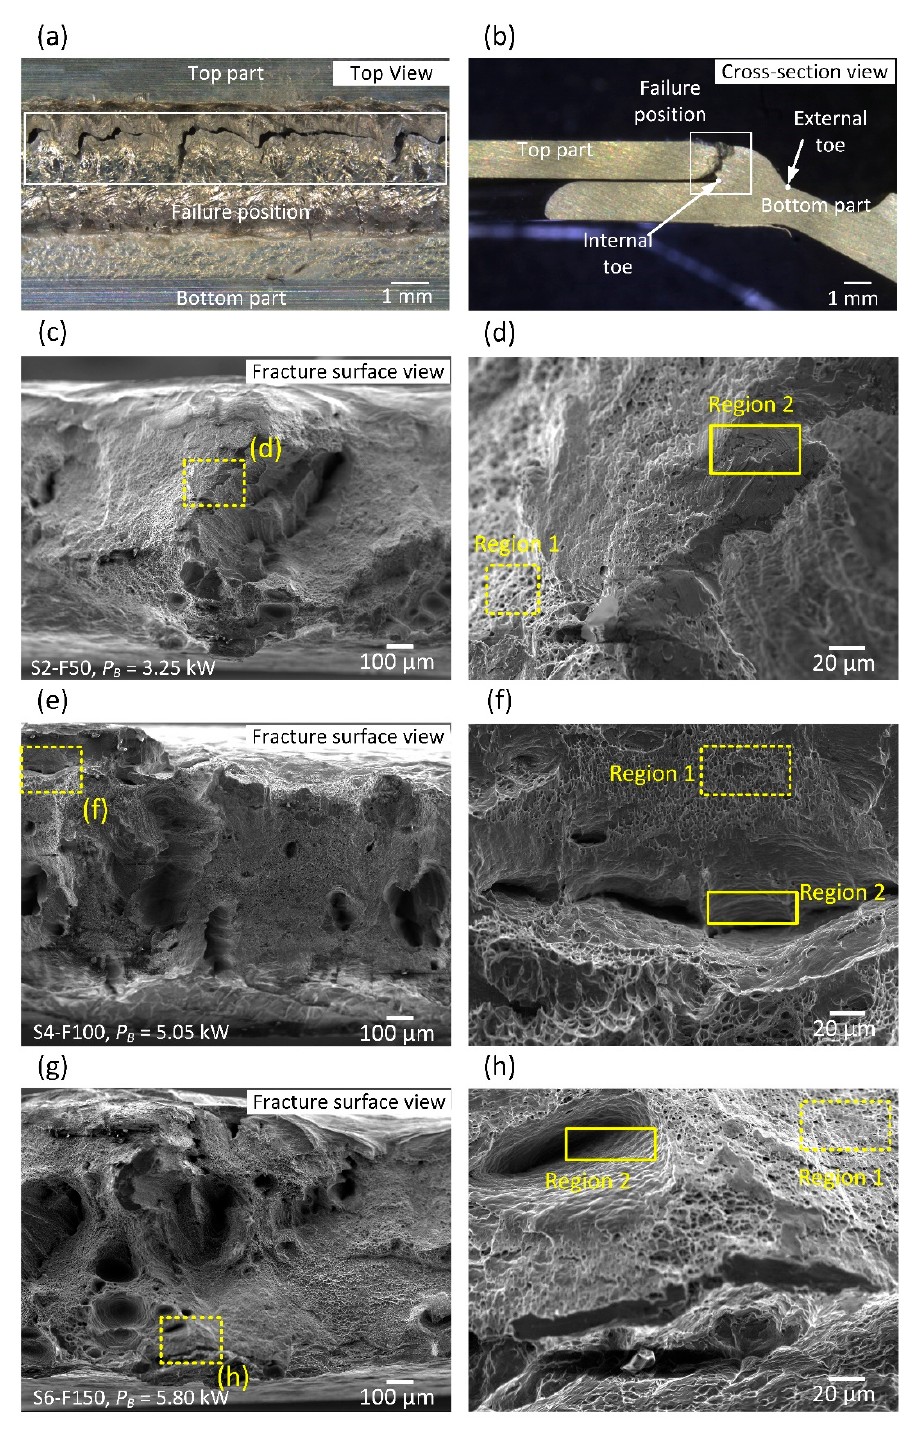
Figure 9. Representative ( a ) top view and ( b ) cross-section view of the failure position during tensile test by optical microscopy; representative fracture morphology of welds by SEM in the processing window of ( c ) S2-F50, ( e ) S4-F100 and ( g ) S6-F150, with the high magnification view in ( d , f , h ), respectively.